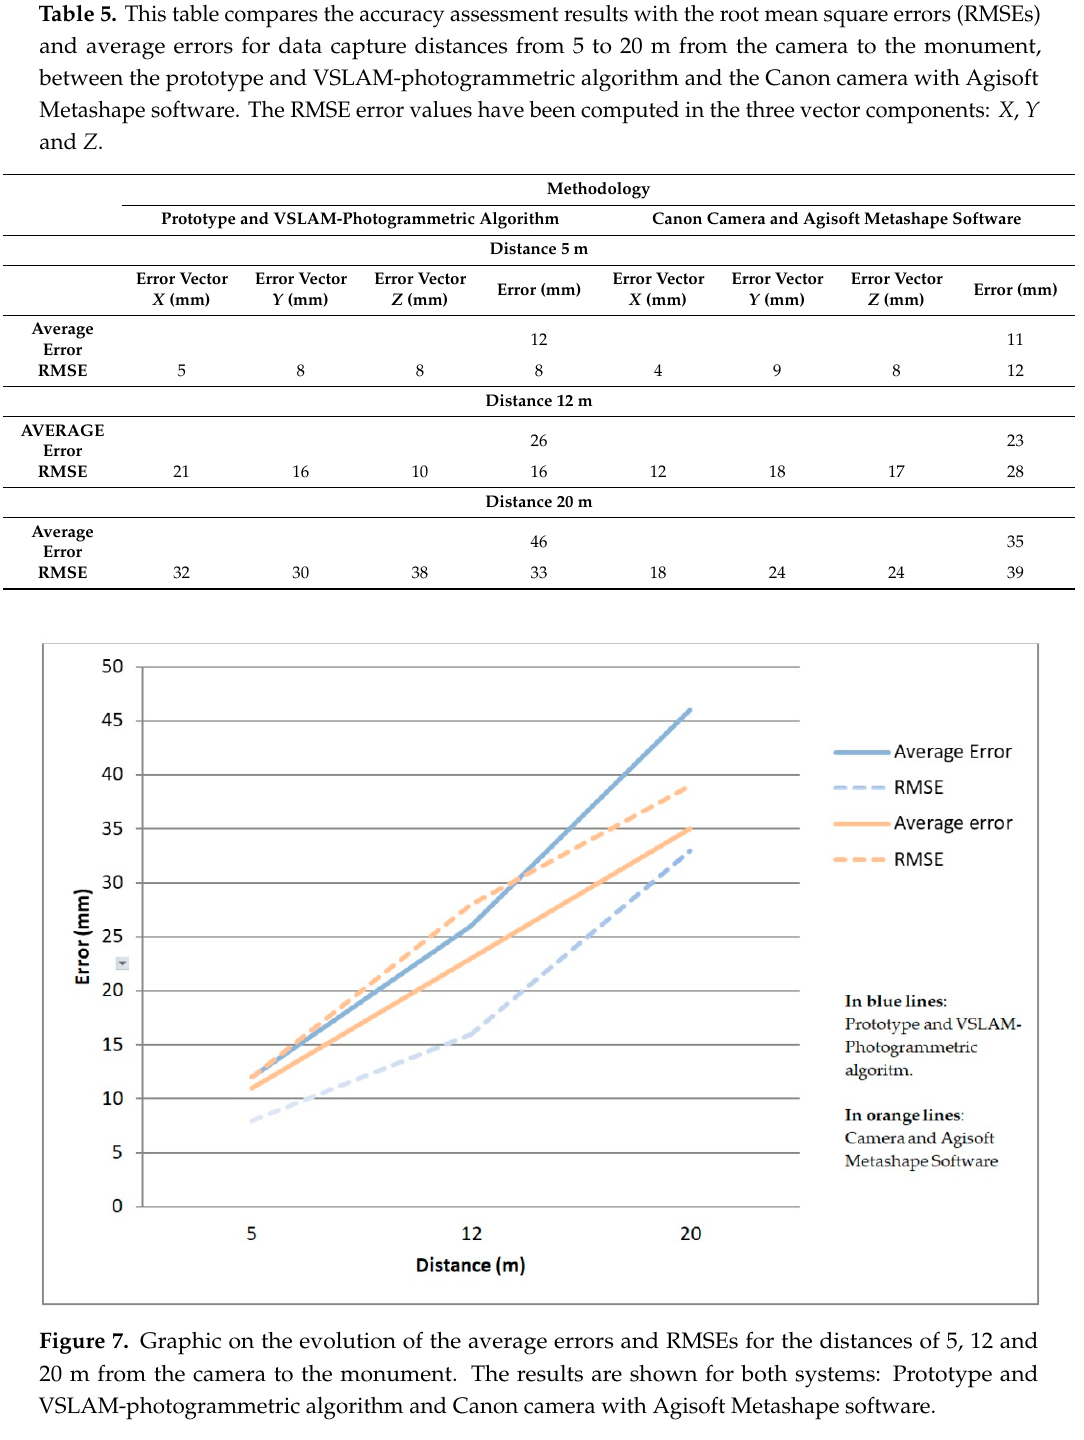
monument, between the prototype and VSLAM-photogrammetric algorithm and the Canon camera components: X , Y and Z .